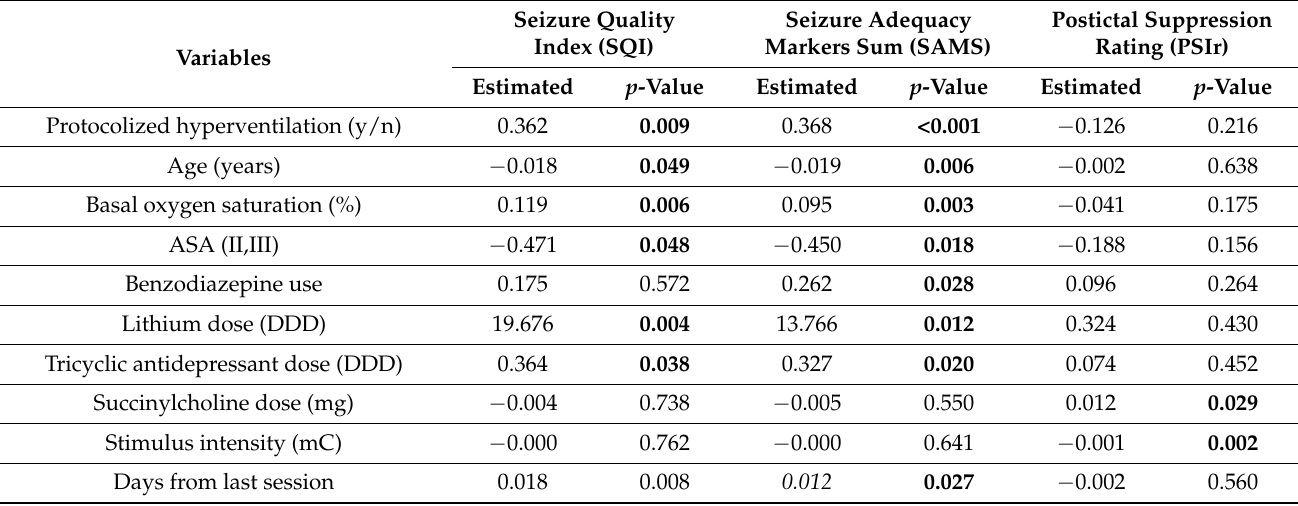
Table 3. Significant variables in univariate repeated measures regression analysis for the seizure quality index (SQI), the seizure adequacy markers sum (SAMS), and the postictal suppression rating (PSI).